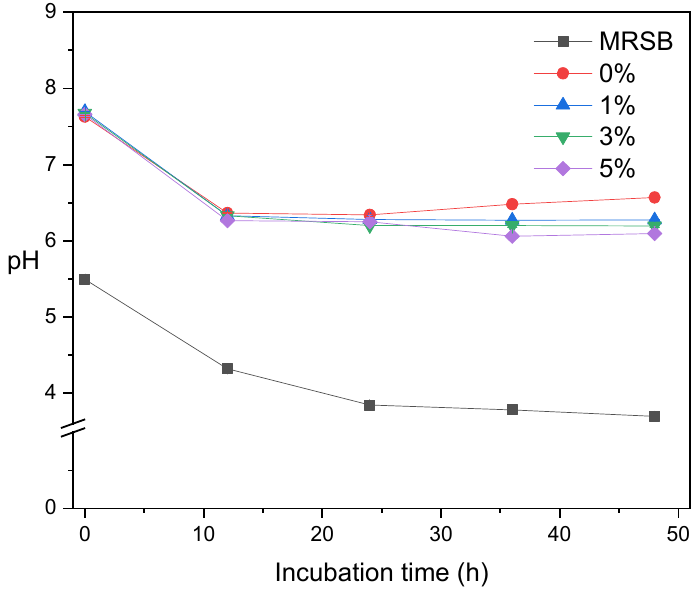
Figure 5. pH profile of MRSB and several MRSm as a function of incubation time. Aachary and Prapulla [25] found that fermentation by L. acidophilus increased butyric acid and total volatile fatty acids. In this study, the number of n-butyric acid in 5% was higher than 0%. This was also observed in the total amount of SCFA. Propionic acid and butyric acid produced from fermentation can prevent colon cancer [28]. In addition, SCFA